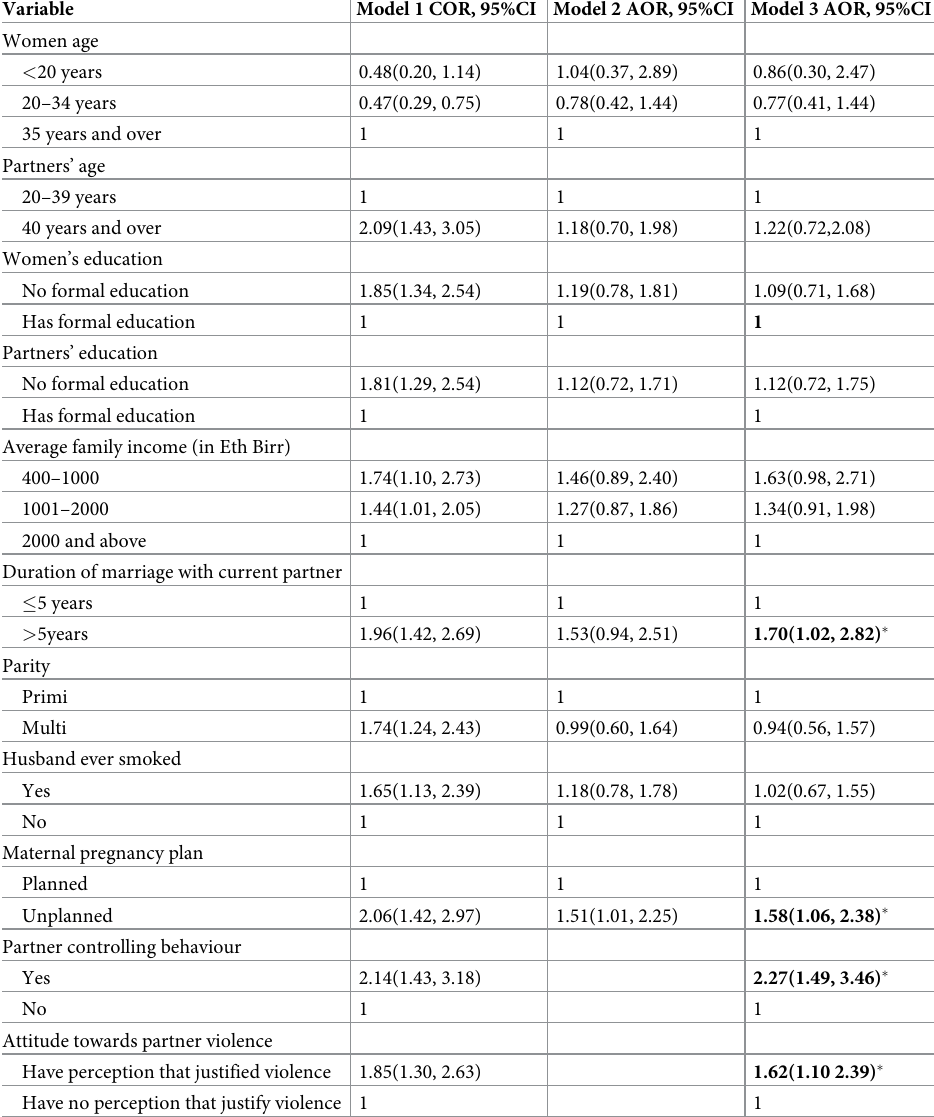
Table 6. Bivariate and multivariate regression of factors associated with partner violence during pregnancy among women who gave birth in public hospitals in Harari regional state, East Ethiopia,